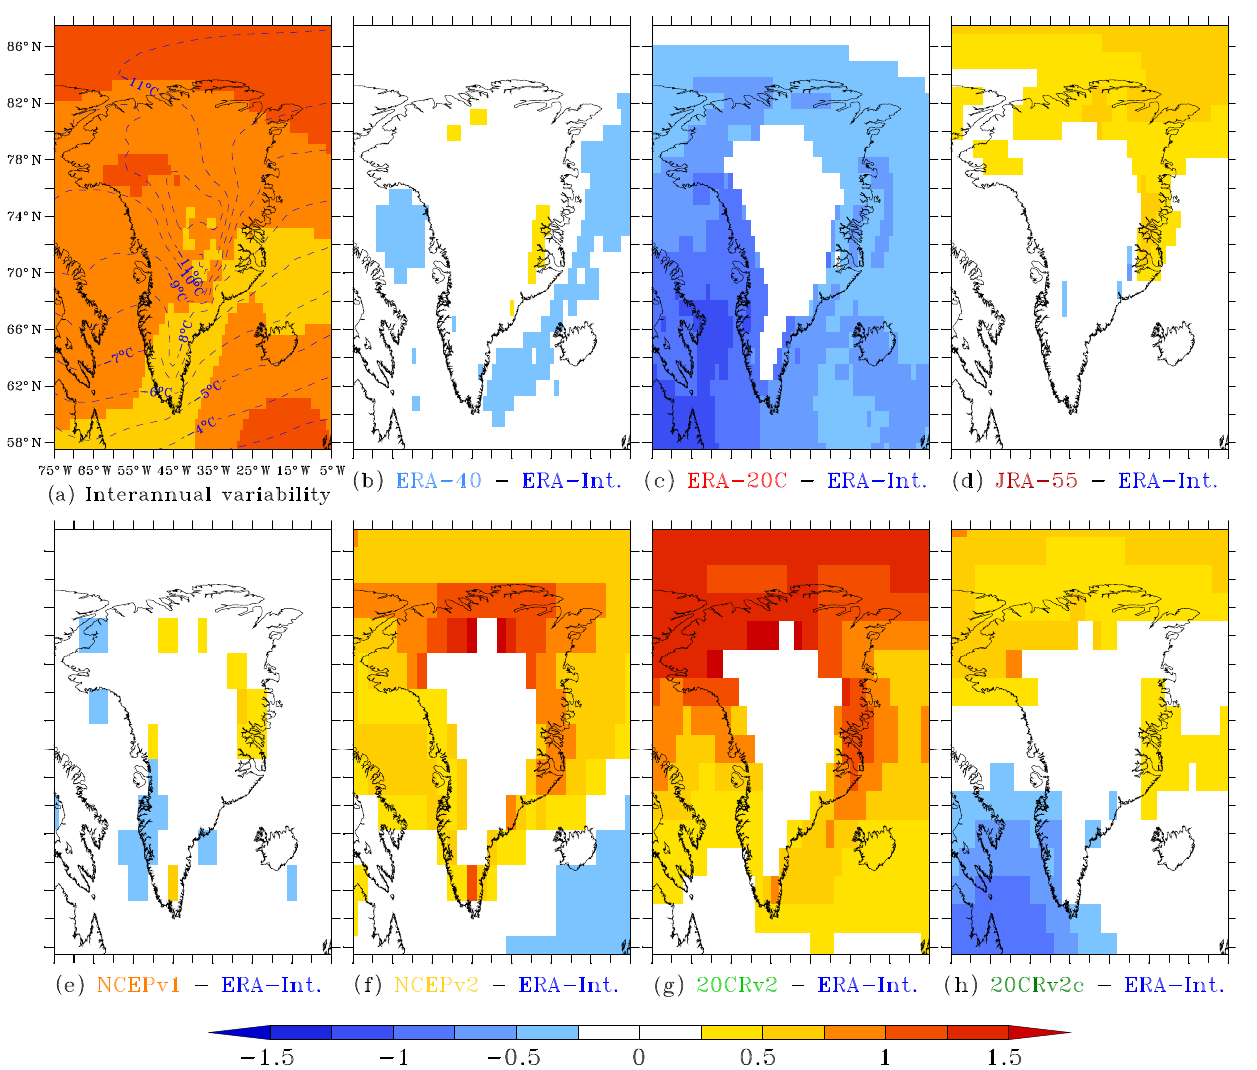
Figure 1. (a) In the background, the interannual variability (i.e. standard deviation) of the JJA mean 700hPa temperature (T700) is simulated by ERA-Interim over 1980–1999. Units are ◦ C. The contours of the mean JJA T700 are plotted in dashed blue. (b) – (h) Mean anomalies of the JJA 700hPa temperature simulated by the different reanalyses used in this study with respect to ERA-Interim over 1980–1999 (in ◦ C). No comparison is shown above 2000ma.s.l. due to the aim of only showing comparisons in the free atmosphere (700hPa), and the datasets are shown here by using their native lat–long projection. Similar figures over different reference periods and at other vertical levels (850 and 500hPa) can be found in the